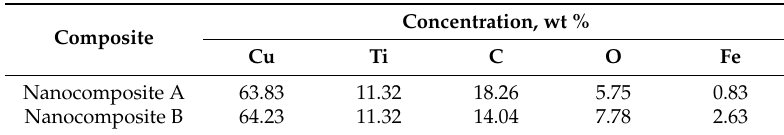
Table 1. EDS analysis of the ball milled TiC–Cu powders, nanocomposites A and B containing 30 vol % TiC.